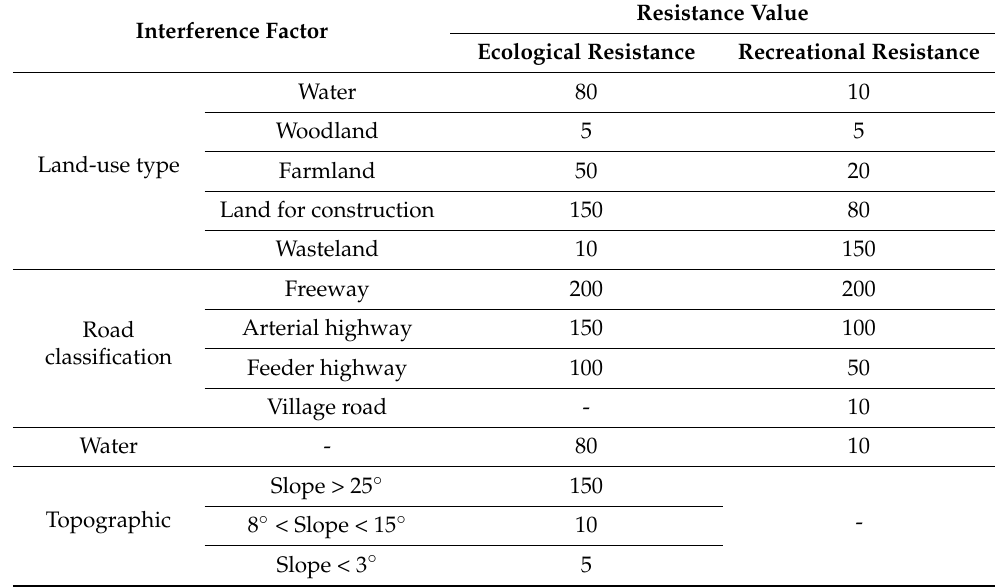
Table 1. Assignment of resistance